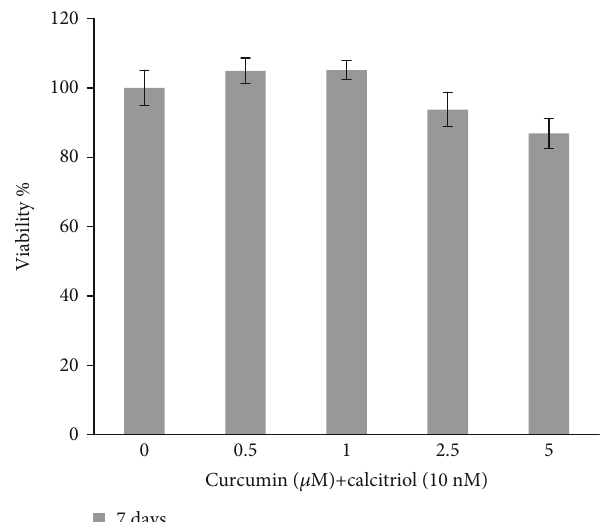
Figure 2: Viability of curcumin and calcitriol combination in 7 days.